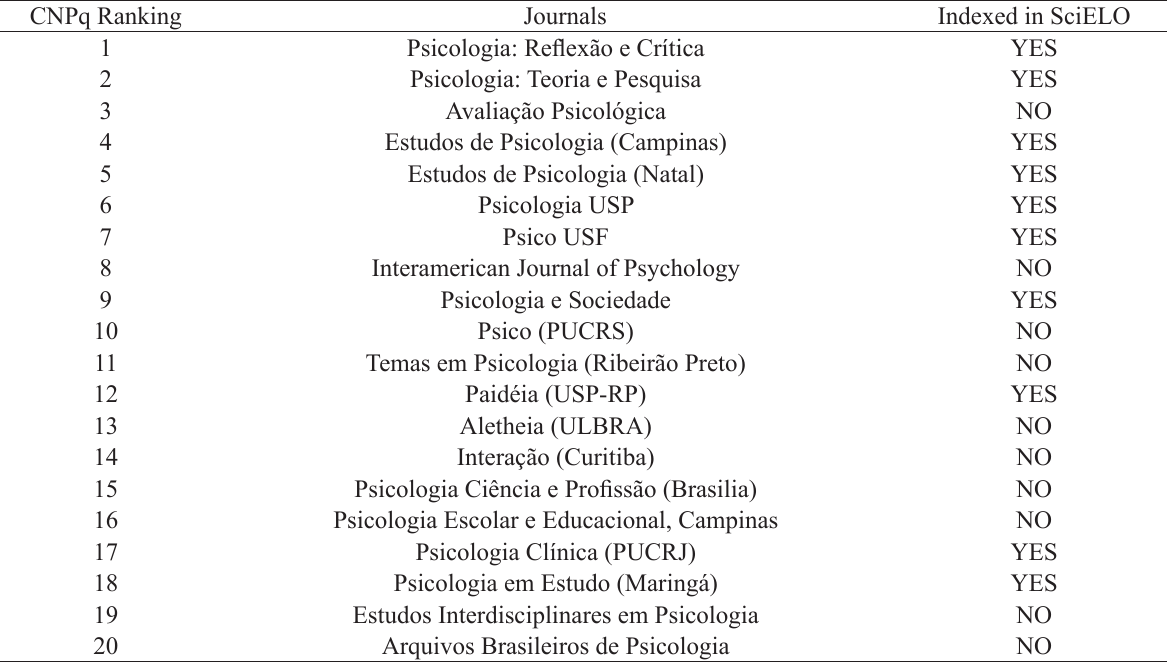
Performance of Top Brazilian Psychology Journals: